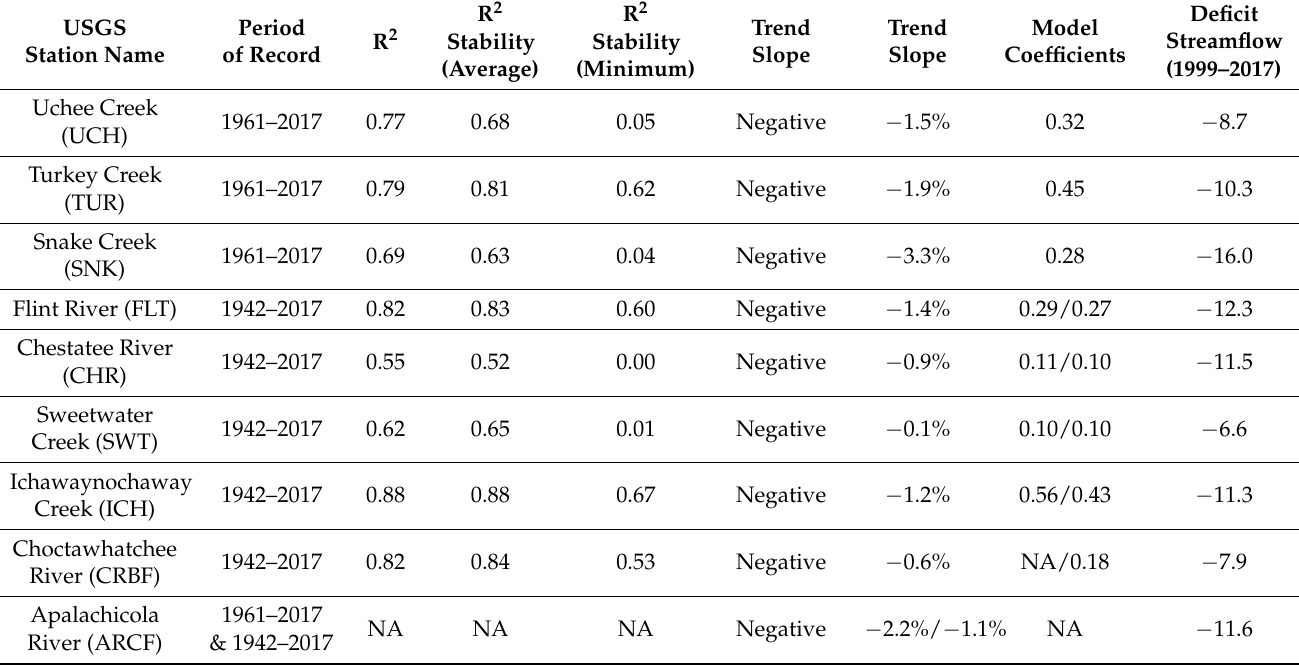
Table 2. Statistical variables of the 9 USGS stations, including: R 2 , R 2 Stability (Average), R 2 Stability (Minimum), Trend Slope (Positive or Negative), Trend Slope (%), Model Coefficients, and Cumulative Deficit Streamflow (1999–2017) measured in Standard